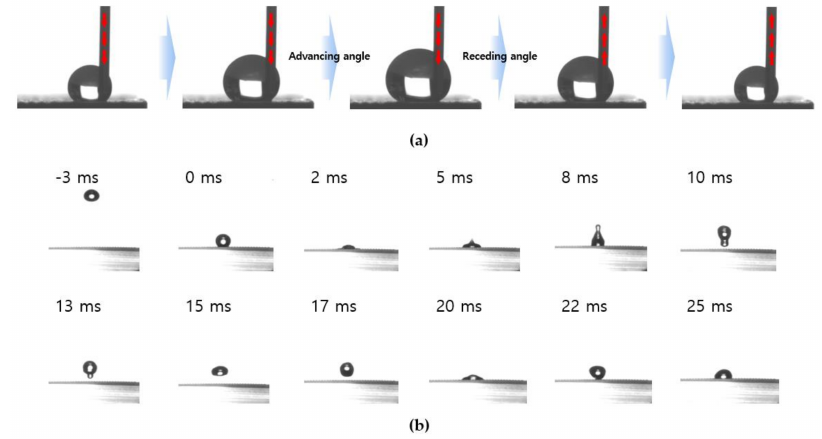
Figure 4. ( a ) Hysteresis and ( b ) time-lapsed images of water droplet shown in a superhydrophobic metal